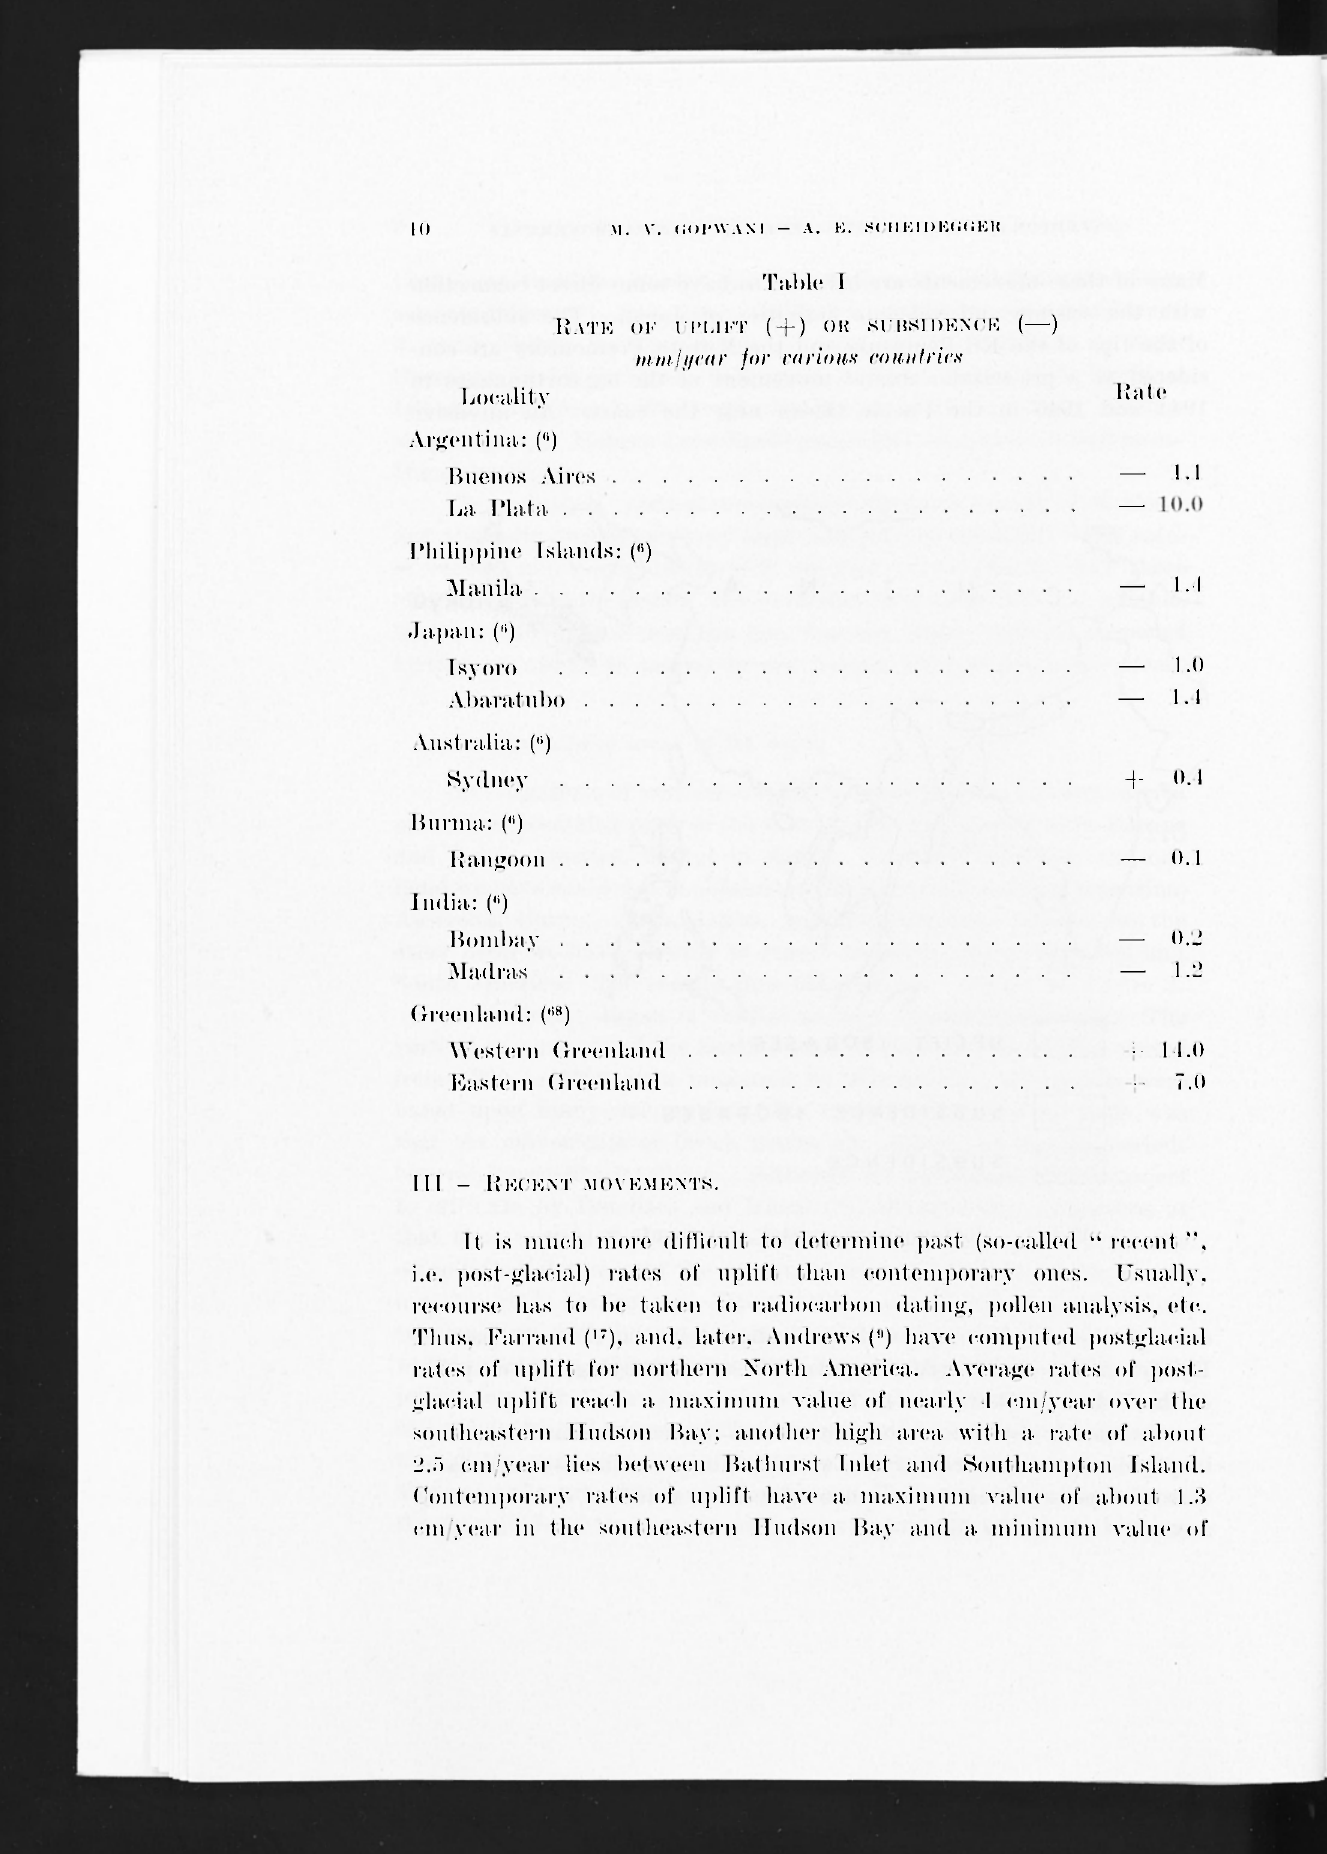
RATE OF I PUFT mm/year for various